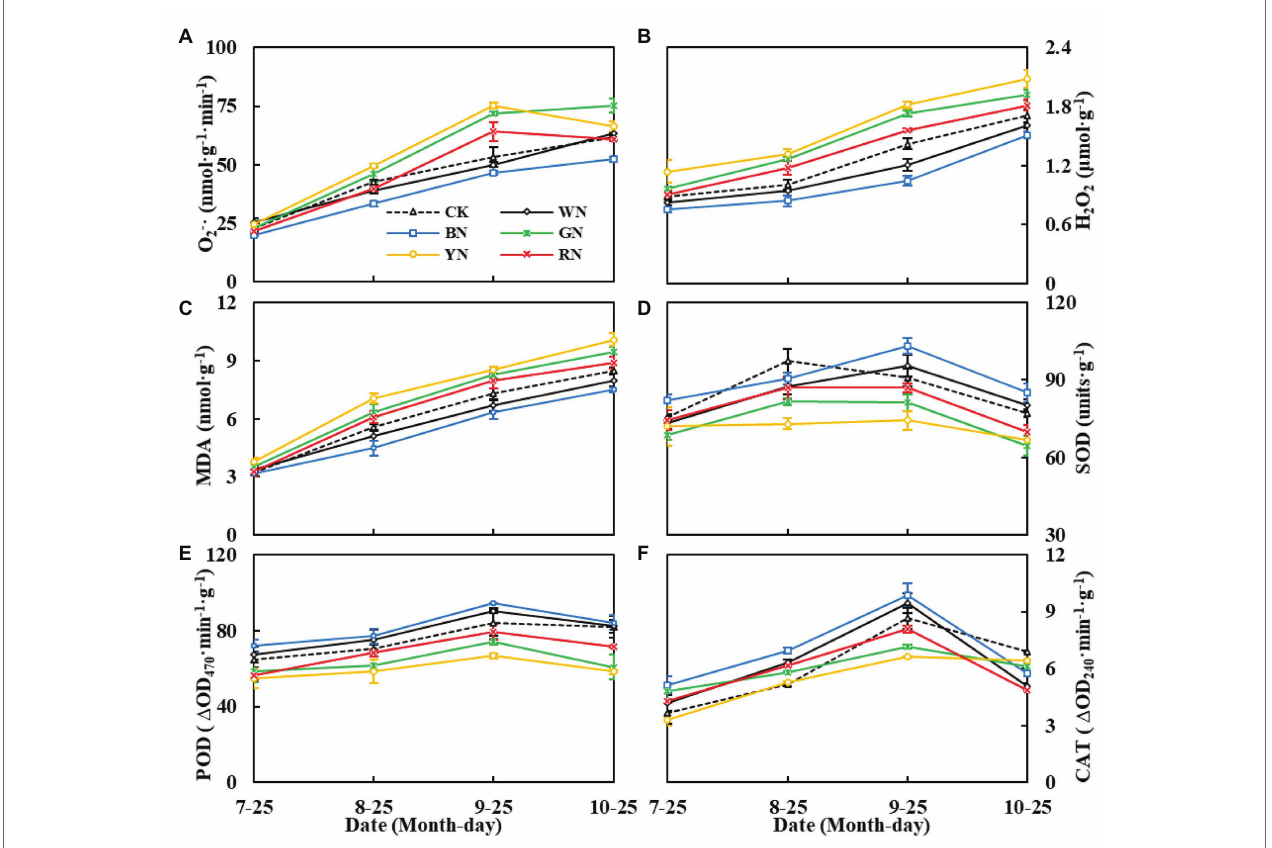
FIGURE 7 | The effect of photo-selective nets on reactive oxygen, malondialdehyde (MDA) contents, and antioxidant enzyme activities of green onion leaves at different growth stages. (A) O 2− (superoxide anion), (B) H 2 O 2 , (C) MDA content, (D) SOD activity, (E) POD activity, (F) CAT activity. CK, control; WN, white photo- selective nets; BN, blue; GN, green; YN, yellow; and RN, red. Values are average ± SD, n = 18. Error bars indicate standard